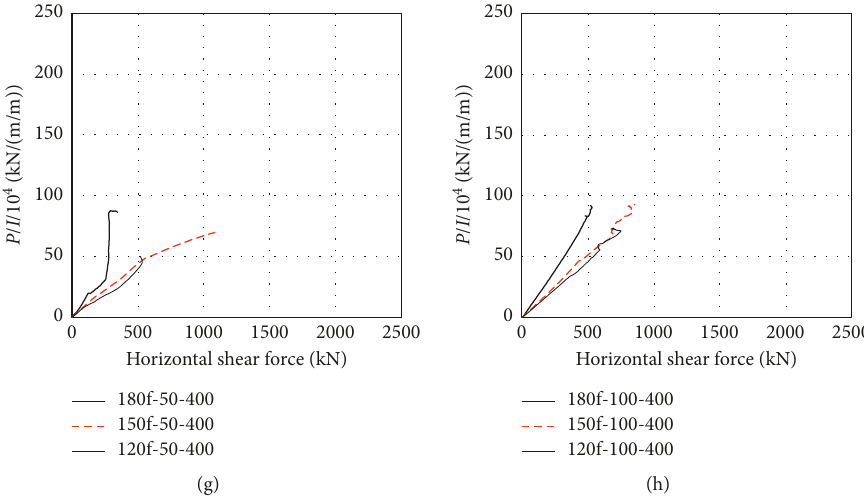
Figure 10: Load-horizontal shear force curves. (a) Slab thickness, stud spacing (50 mm, 50mm); (b) slab thickness, stud spacing (100mm, 50mm); (c) slab thickness, stud spacing (50mm, 100 mm); (d) slab thickness, stud spacing (100mm, 100mm); (e) slab thickness, stud spacing (50mm, 200mm); (f) slab thickness, stud spacing (100mm, 200 mm); (g) slab thickness, stud spacing (50mm, 400mm); (h) slab thickness, stud spacing (100mm,